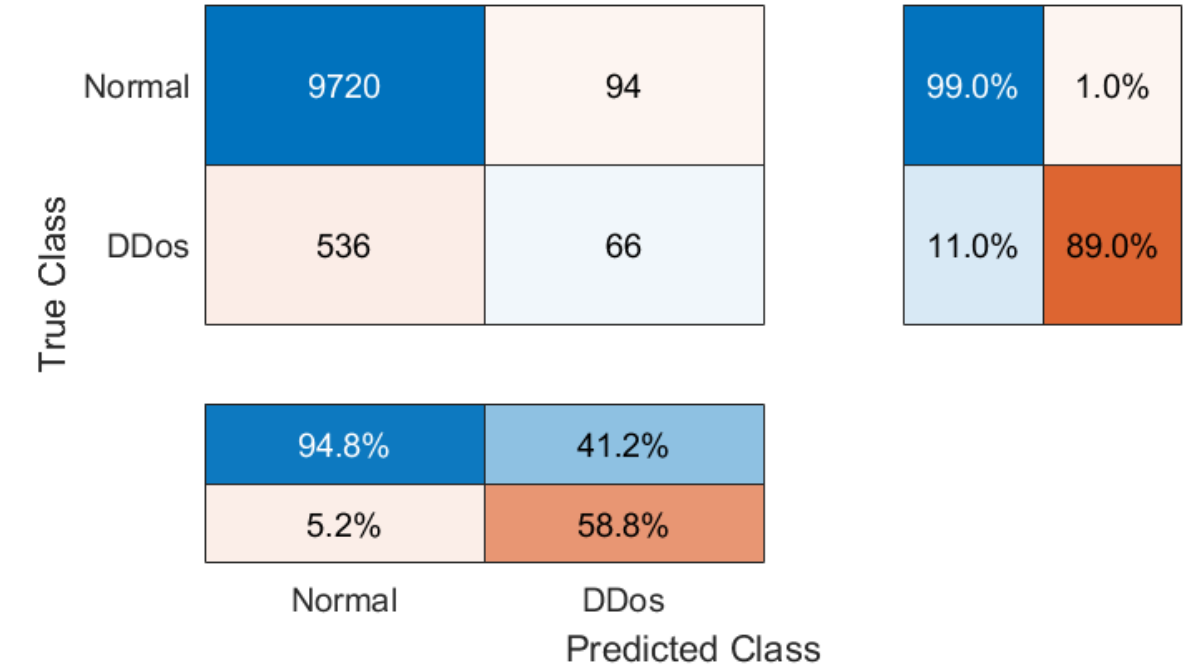
Figure 9. Confusion matrices visualizing the performance of TTL with ResNet50 architecture: ( a ) for